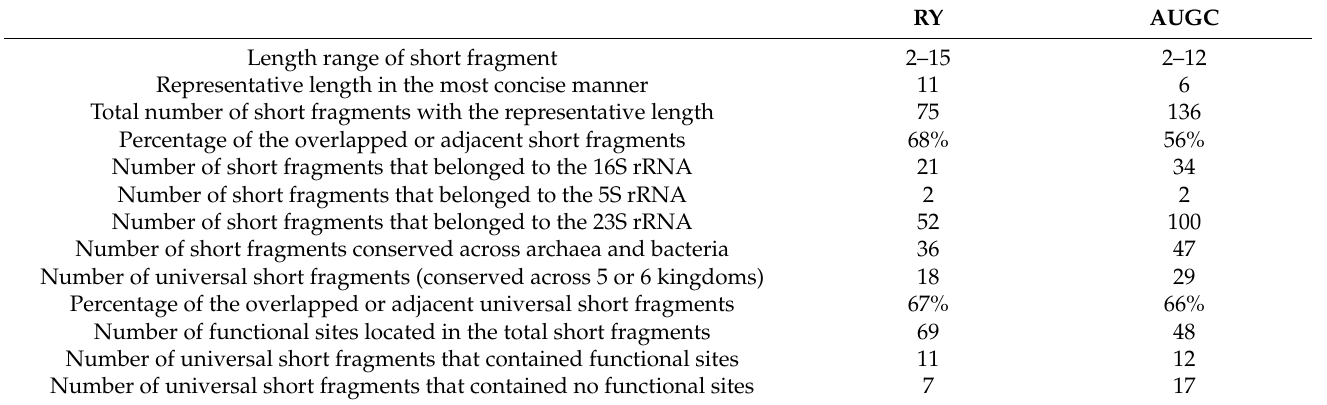
fragments in RY and AUGC